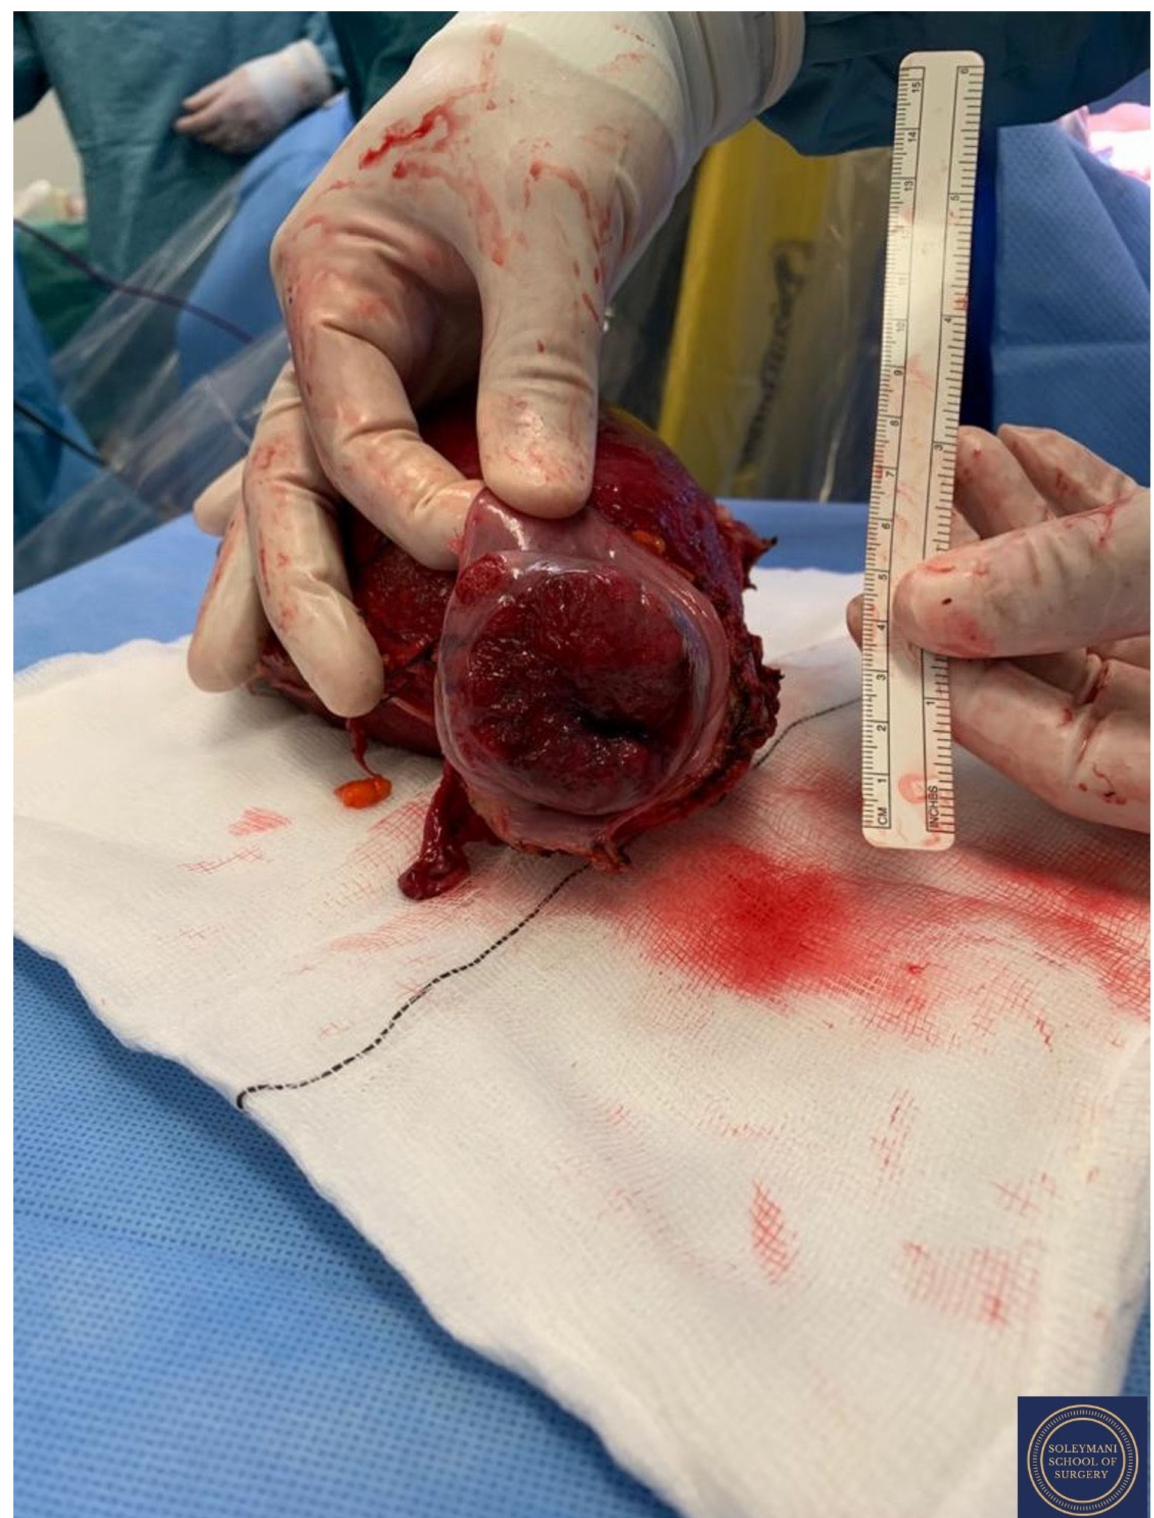
Figure 18. Appearance of the cervical exophytic mass on the final